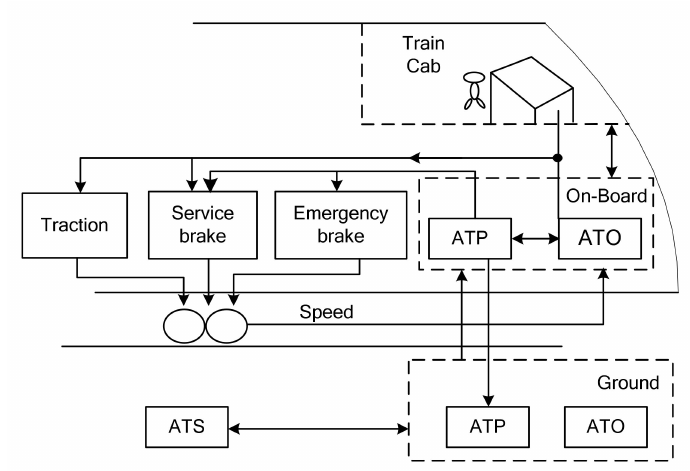
Figure 1. Composition diagram of ATO